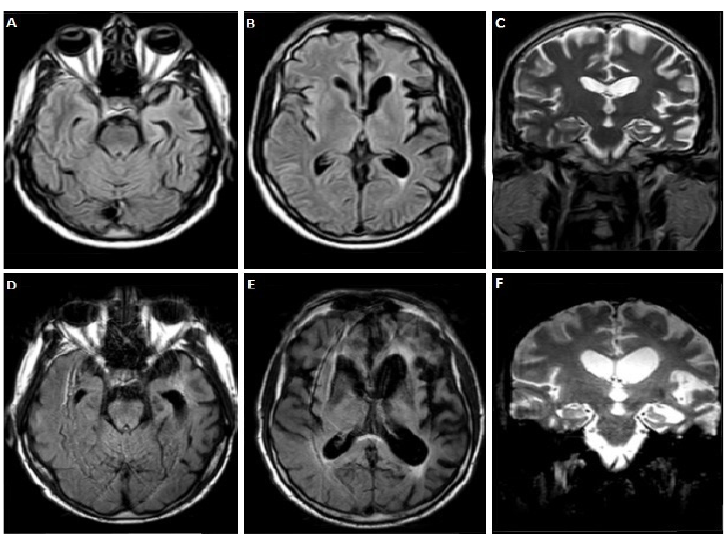
Figure 2. Brain MRI of case 2 at age 57 ( A – C ) and 60 ( D – F ) showing some degree of cortical atrophy in frontal and temporal lobes was observed with left predominance that deteriorated significantly three years later.